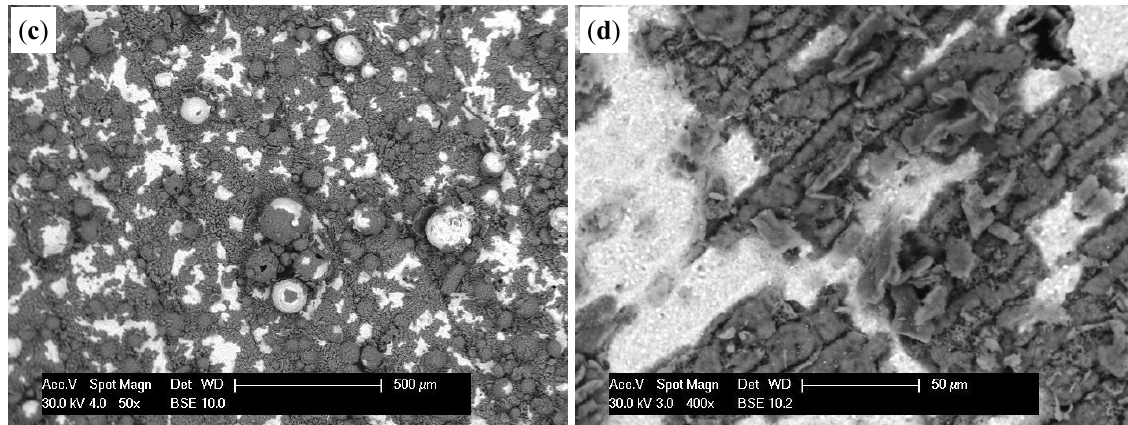
Figure 8. The formation of an oxide layer on the specimen after oxidation at 1200 °C: 5 h ( a ); 10 h ( b ); 50 h of A-sample ( c ); and 50 h on grinding surface of B-sample ( d ). Color descriptions are shown in Figure